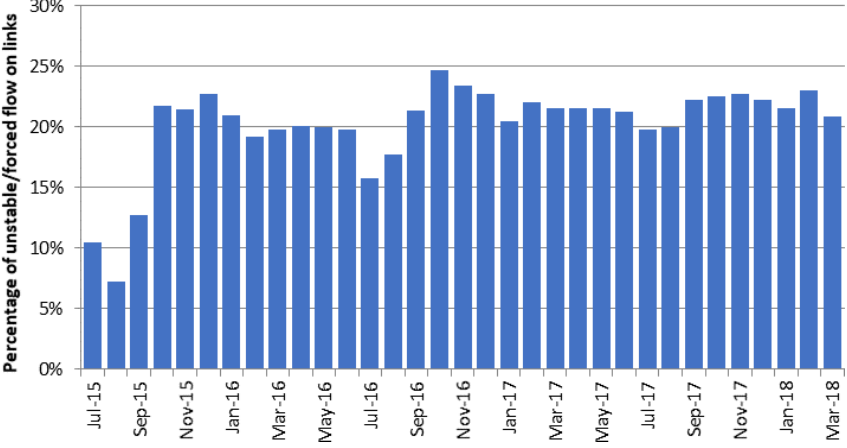
Figure 10: Percentage of unstable/forced flow on links